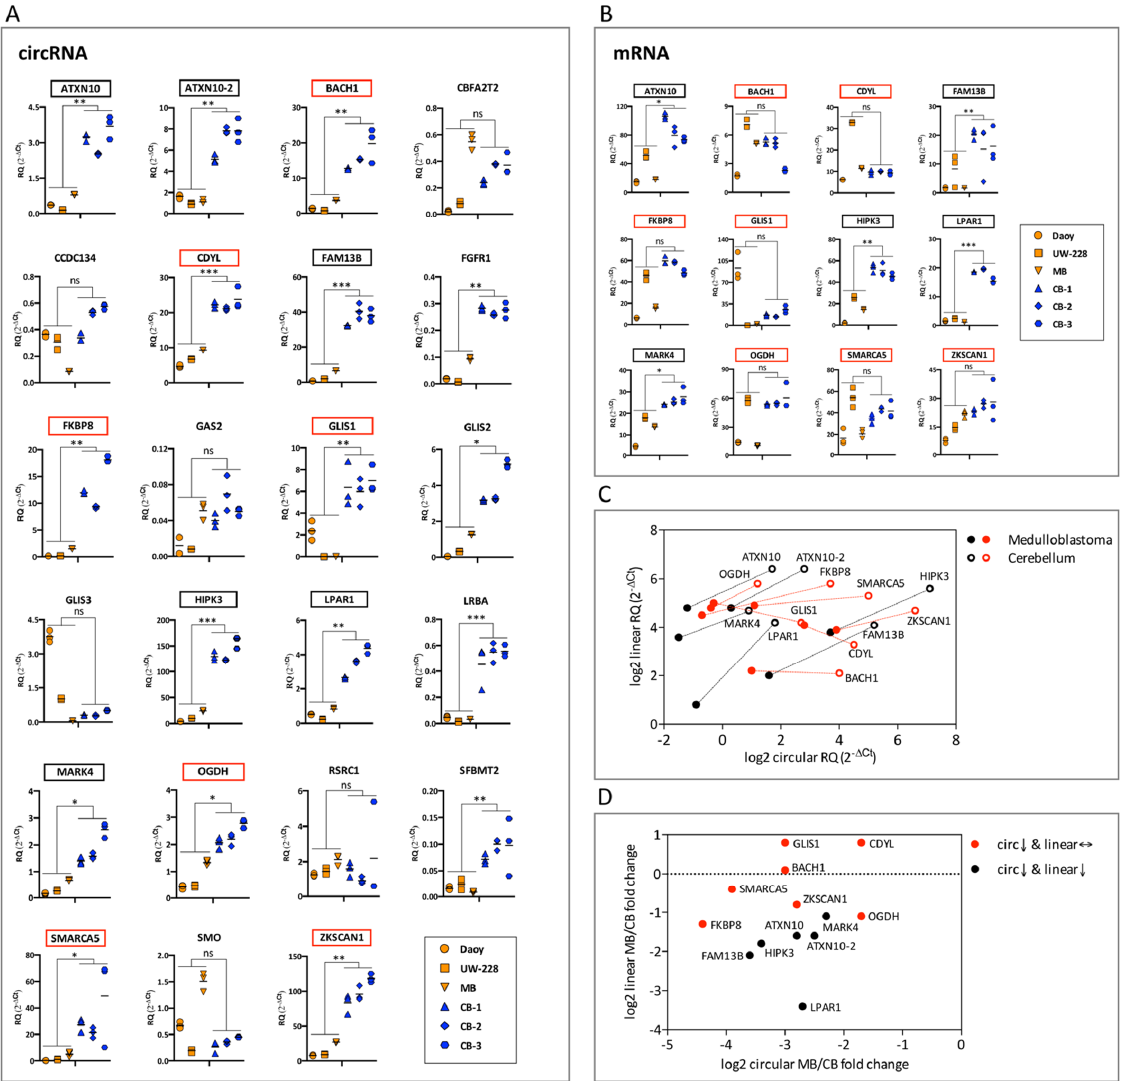
Figure 3. Differentially expressed circRNAs in medulloblastoma and cerebellum. ( A ) qPCR analysis of circRNAs in medulloblastoma (Daoy, UW-228, and a SHH medulloblastoma human sample) versus cerebellum (three independent human samples). RNA expression is presented as relative expression (2 − ∆ Ct values), normalized to the housekeeping gene (TBP). Short lines indicate the mean of the technical replicates per sample. RQ denotes the relative quantification of the RNA expression. Multiple t-test using the Benjamini and Hochberg method ( p values computed while not assuming consistent SD) was applied to calculate statistically significant differences (*: p < 0.05, **: p < 0.01 and ***: p < 0.001) between the medulloblastoma versus the cerebellar samples. The selected 13 circRNAs are highlighted in red or black boxes depending on the expression of their corresponding mRNAs. ( B ) qPCR analysis in medulloblastoma versus cerebellum of the 12 mRNAs originating from the same gene as the 13 selected circRNAs. The analysis was performed as in ( A ). Red boxes highlight mRNAs that remain unchanged in medulloblastoma, while black boxes mRNAs were downregulated in medulloblastoma. ( C ) Correlation of expression in medulloblastoma and in cerebellum of the selected 13 circRNAs with their corresponding linear mRNAs. The log 2 of the mean expression (2 − ∆ Ct values) in medulloblastoma (filled dots) and in cerebellum (hollow dots) of circRNAs (x axis) and the linear mRNAs originating from the same gene (y axis) is presented. Red dots highlight circRNAs significantly downregulated in medulloblastoma, while their corresponding mRNAs remain unchanged, and black dots circRNAs whose corresponding mRNAs are also downregulated in medulloblastoma. Lines connect the individual gene expression in cerebellum and medulloblastoma. ( D ) Correlation of the fold change in expression in medulloblastoma versus cerebellum of the selected 13 circRNAs with their corresponding linear mRNAs. The log 2 -fold change of the mean expression (2 − ∆ Ct values) in medulloblastoma versus cerebellum (MB/CB) of circRNAs (x axis) and the linear mRNAs originating from the same gene (y axis) is presented. Red and black dots are as in panel ( C